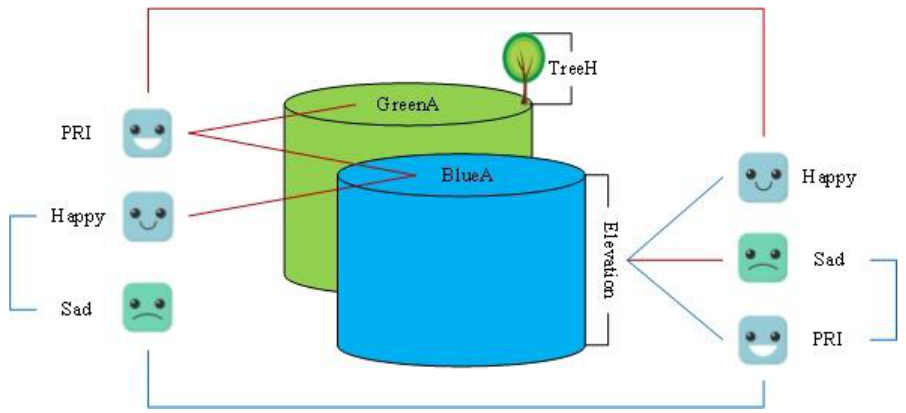
Figure 5. Conceptual descriptions of spearman correlations between landscape metrics and facial expression scores. Lines in red bridge two parameters with a positive relationship, and lines in blue with a negative. Abbreviations: GreenA, green-space area; blueA, blue-space area; TreeH, tree height; PRI, positive response index.